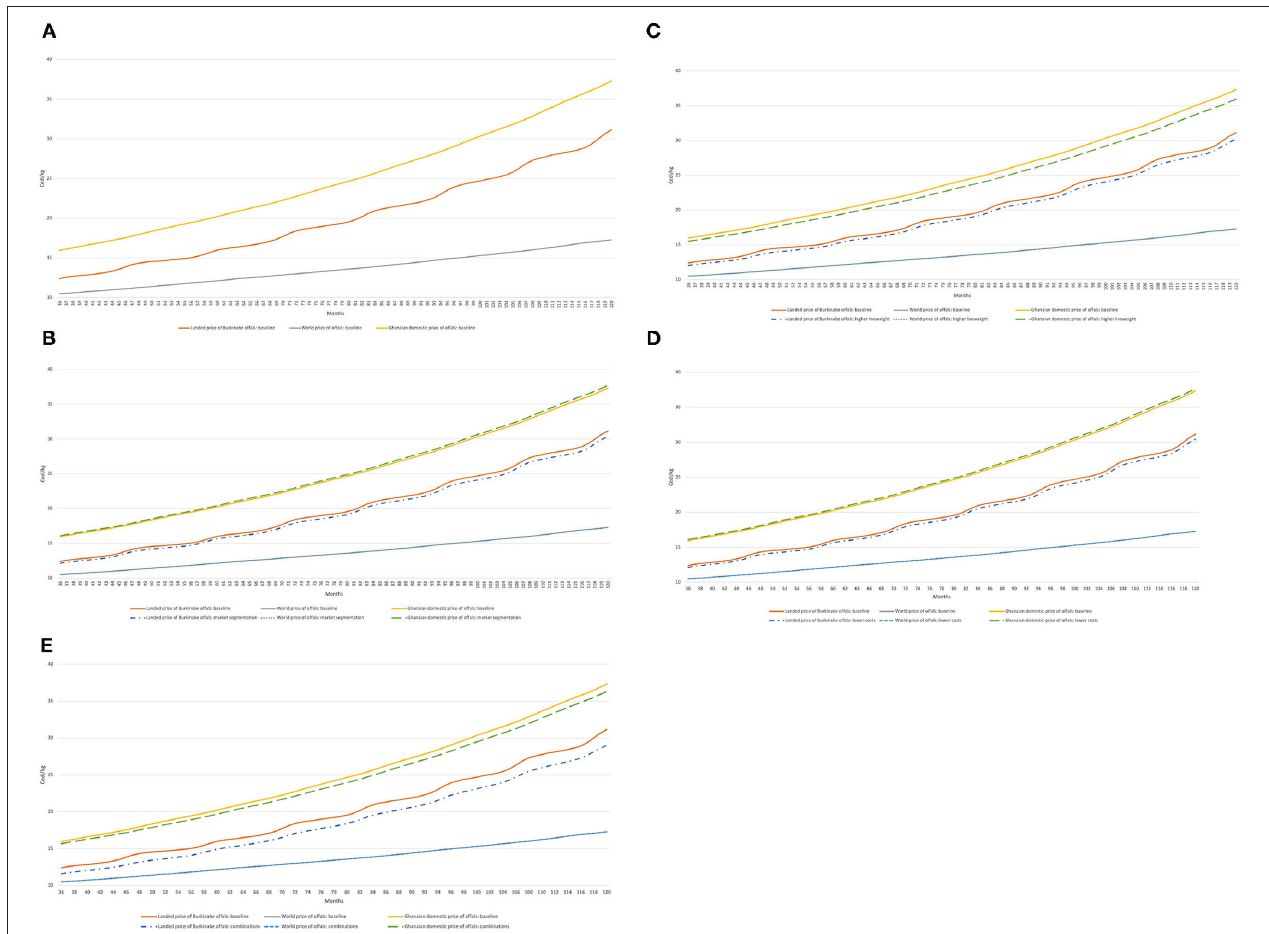
FIGURE 5 | Evolution of offal prices in Burkina Faso, Ghana, and world markets (Cedi/kg) under alternative strategies. (A) Baseline. (B) A price segmentation strategy. (C) Improved animal productivity. (D) A reduction in marginal costs in processing in Burkina Faso. (E) A combination of strategies (B) , (C) , and (D) . Model